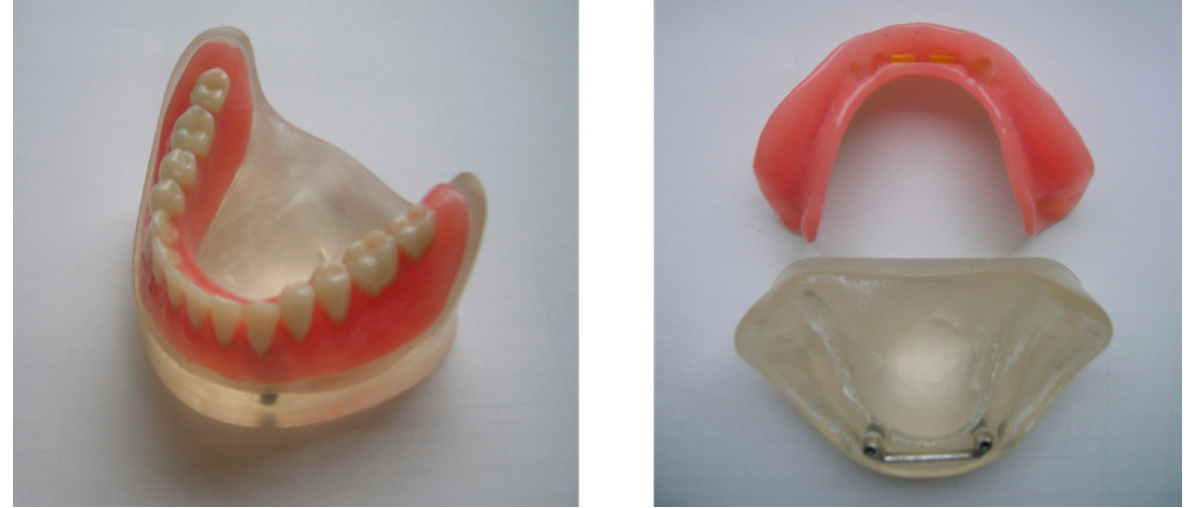
Figure 1. A model of an edentulous mandible with implants, a bar, and a complete denture.